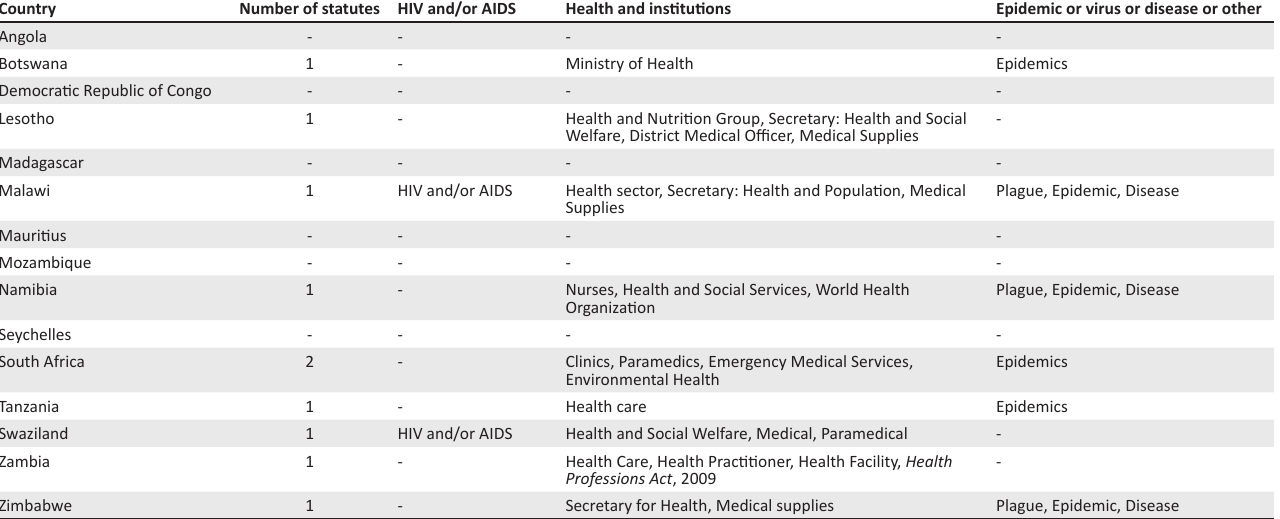
TABLE 5: Words mentioned in the statutes analysed. Country Number of statutes HIV and/or